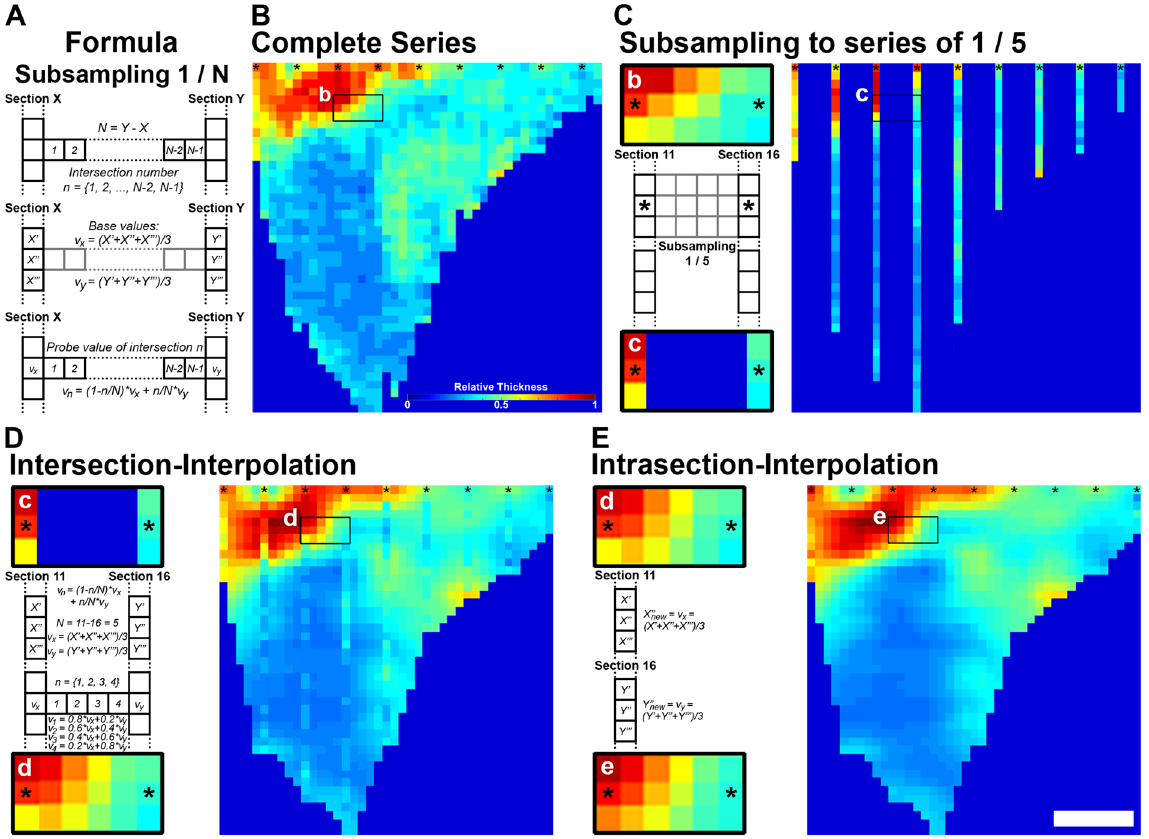
Figure 5. Interpolation of heatmaps after 1/5 subsampling. (A) Formula for intersection-interpolation. (B) Heatmap representing the thickness of the lateral wall in a complete series of sections. (C–E) Heatmaps representing values obtained for a 1/5 subsampling, without interpolation ( C ), following “intersection- interpolation” ( D ) and “intrasection-interpolation” ( E ). Formula are presented on the left as well as a cropping of a region of reference for all heatmaps. Scale bar: ( B ) = colour coded relative thickness; ( E ) = 500 µ m. See also Supplementary Figs